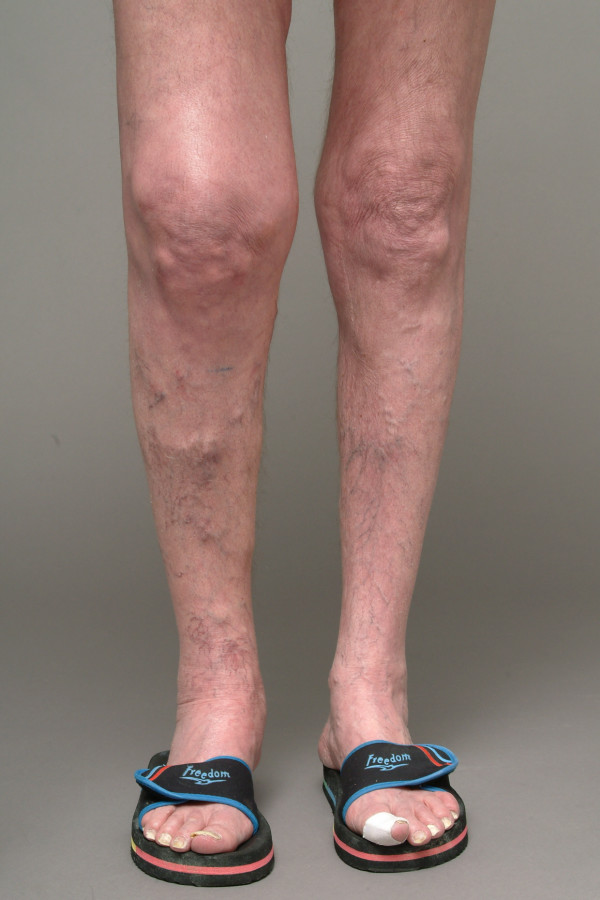
Clinical picture.